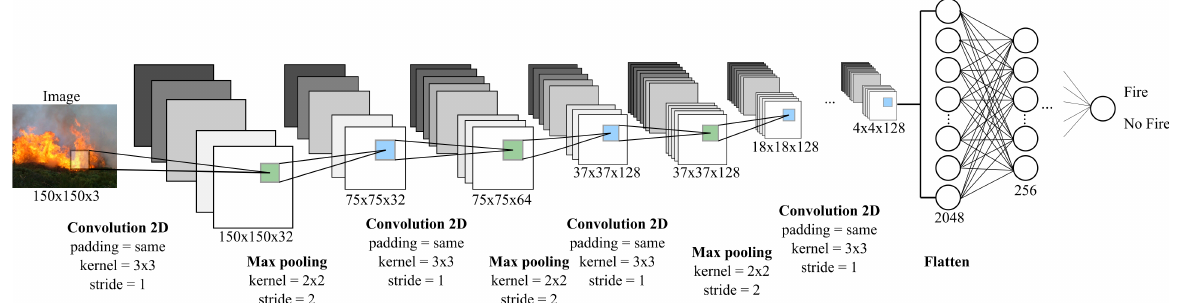
Figure 5. Illustrated architecture of LW-FIRE150 CNN model used for wildfire image